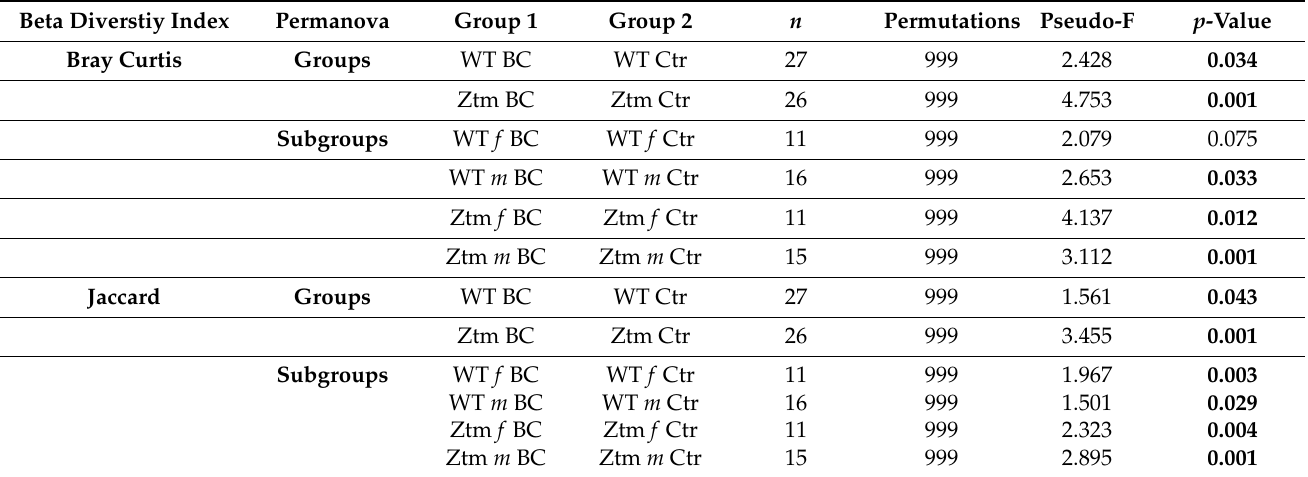
Table 3. Beta diversity of the intestinal microbiota. Beta diversity showing the degree of pair-wise similarity in species composition between the groups assessed by Bray–Curtis and Jaccard matrices. Similarity measures of abundance, presence, and absence data of species, genera, families, orders, classes, and phyla was assessed in the four groups, WT (BC & Ctr) and Ztm (BC & Ctr), post BC treatement. WT = wild-type mice; BC = bovine colostrum treatment; Ctr = control mice; f = female; m = male; n = number of mice in each